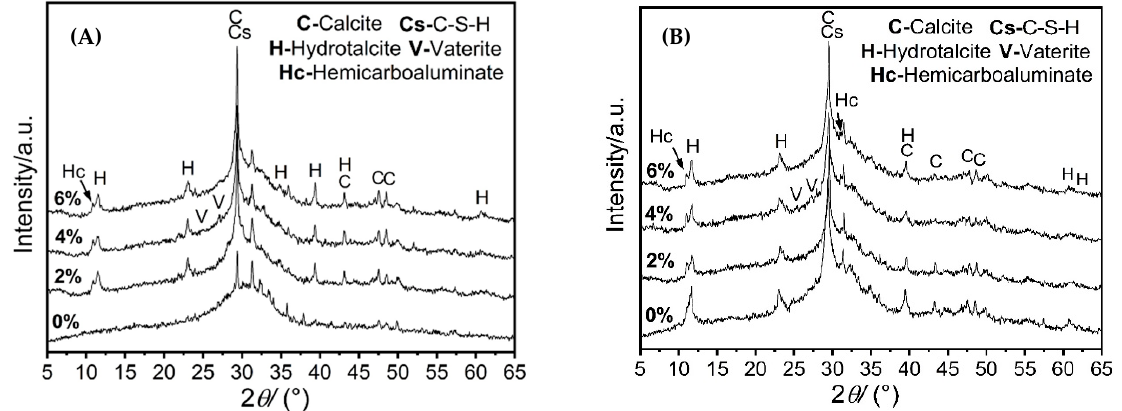
Figure 6. Phase characterization of samples with C-S-H seeds at different curing ages: ( A ) 1 d and ( B ) 28